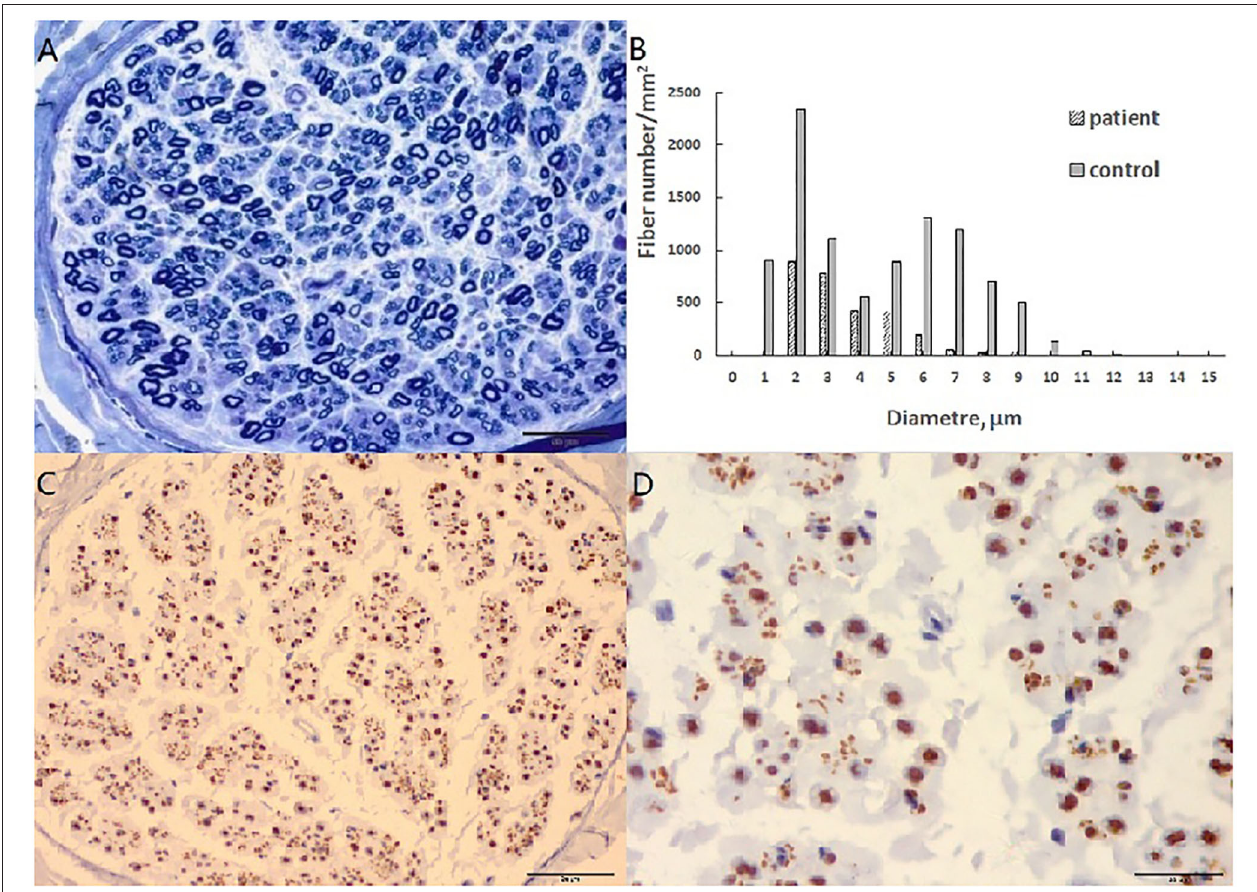
FIGURE 1 | Sural biopsy in cblC disease. (A) Diffuse loss of myelinated fibers, predominant the large myelinated fibers. (B) Histograms of myelinated fibers, the entity is the control, and the slash is the patient with loss of large myelinated fibers. (C) Moderate loss of axons with different diameter. (D) High magnificent showed unmyelinated fibers loosely distributed without a normal cluster profile. Scale bar = 50 µ m in (A,C) . Scale bar = 20 µ m in (D)